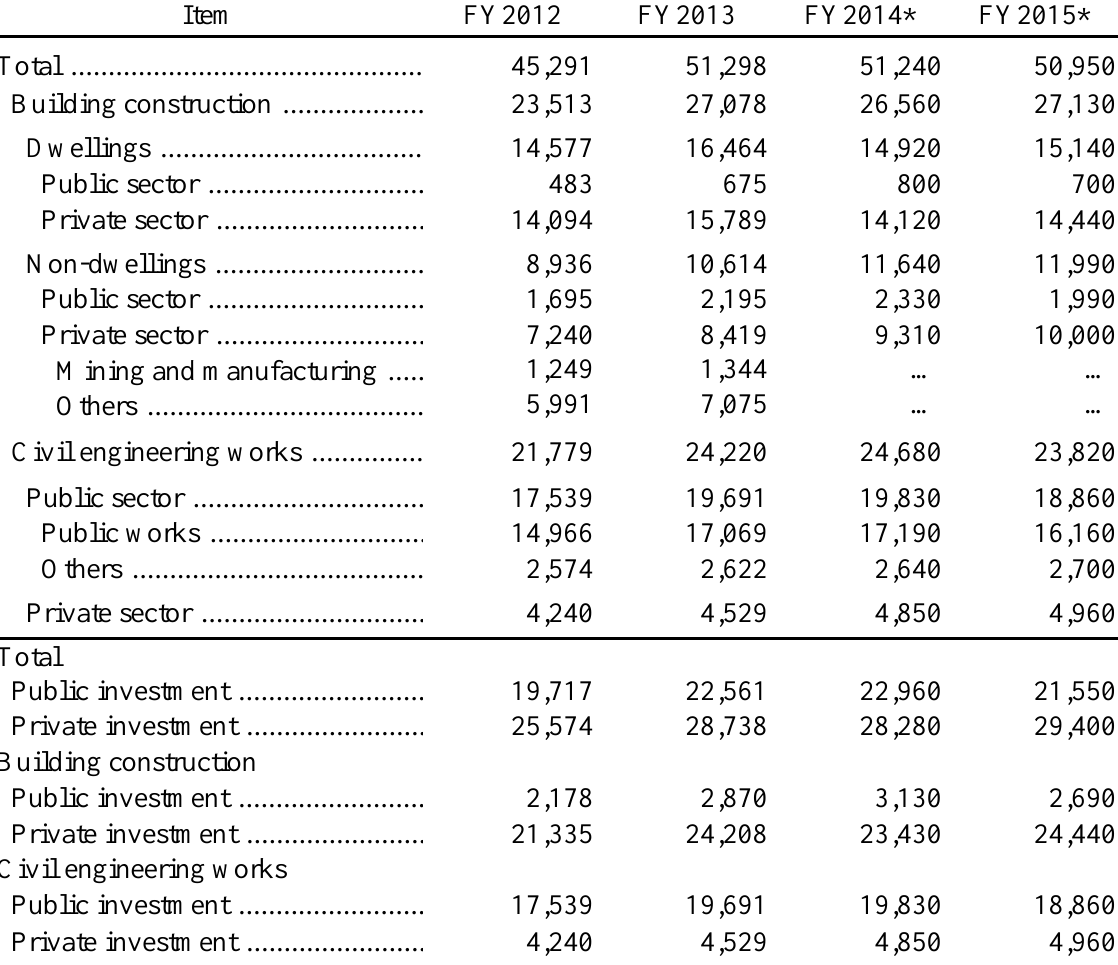
Construction Investment (Current